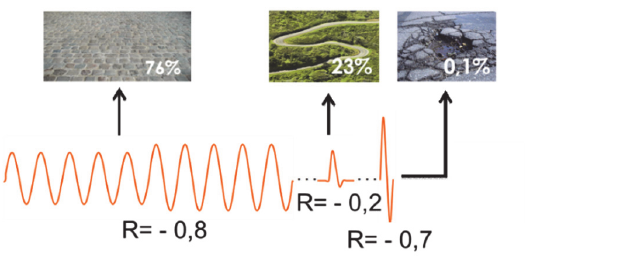
Figure 5: Simplified ‘representative’ fatigue load spectrum.